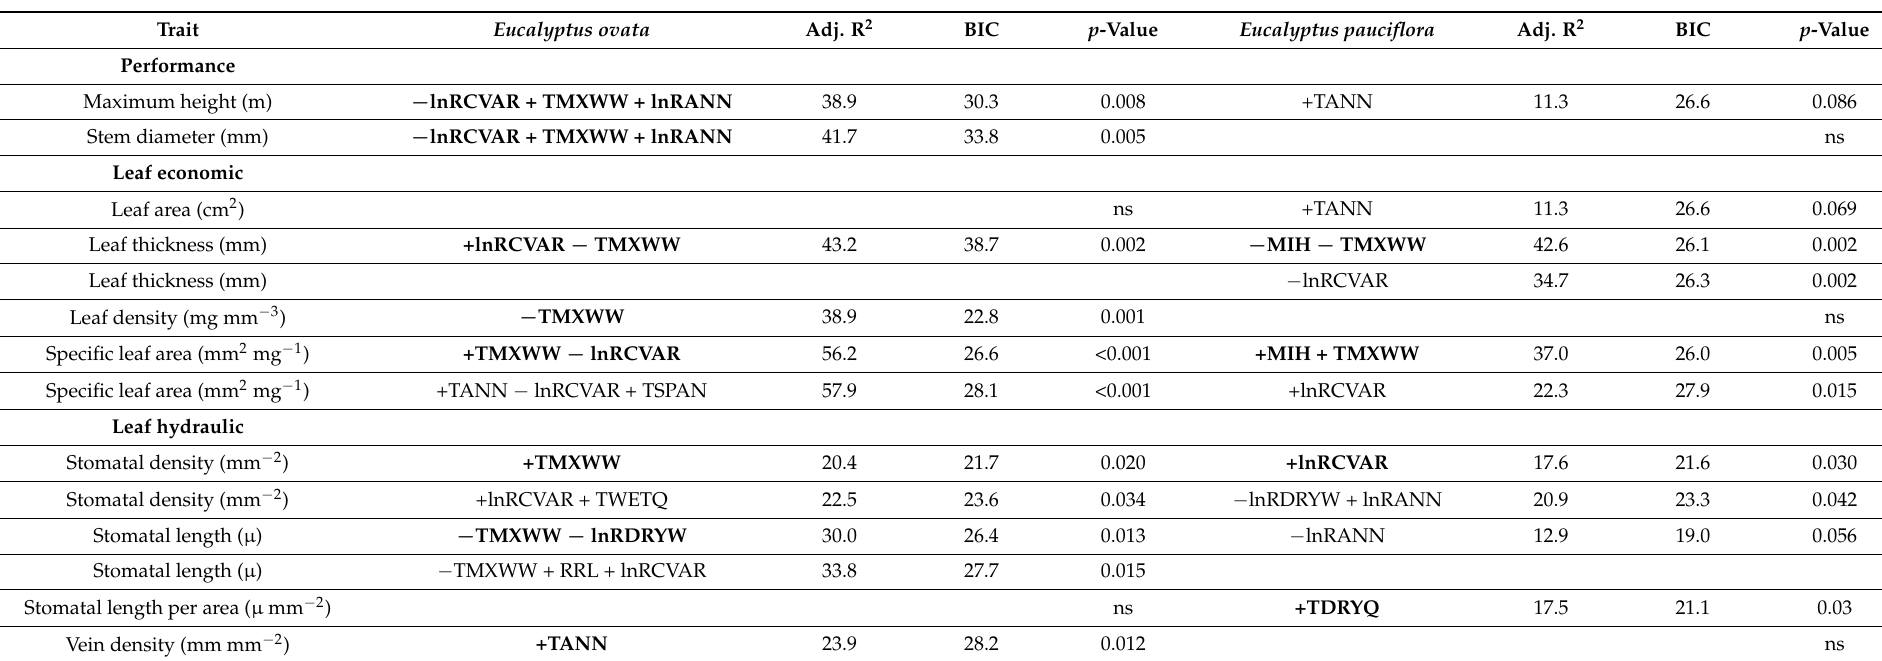
Table 6. Best multiple linear regression models relating performance and leaf traits to climate variables for E. ovata and E. pauciflora (22 populations per species). Models were selected from those where a statistically significant ( p < 0.05) overall model fit was obtained and all climate predictors included in the model were significant at the 5% nominal level, unless only marginally nonsignificant models ( p ≤ 0.1) were available. A maximum of three predictors were permitted per candidate model compared in model selection, and alternative models are shown when the adjusted R 2 or Bayesian information criterion (BIC) values were similar. The signs preceding each climate predictor variable refer to an increase (+) or a decrease ( − ) expected in the dependent variable for a unit increase in the predictor, while holding the other predictors in the model constant. Models with a statistically significant overall model fit and the lowest BIC are bolded. Estimates of the regression coefficients are provided in Table